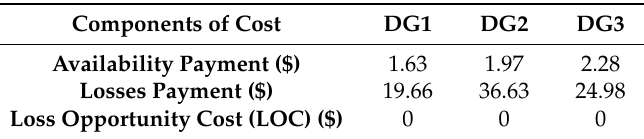
Table 5. The break-down of the QPF of DGs in Scenario 1.